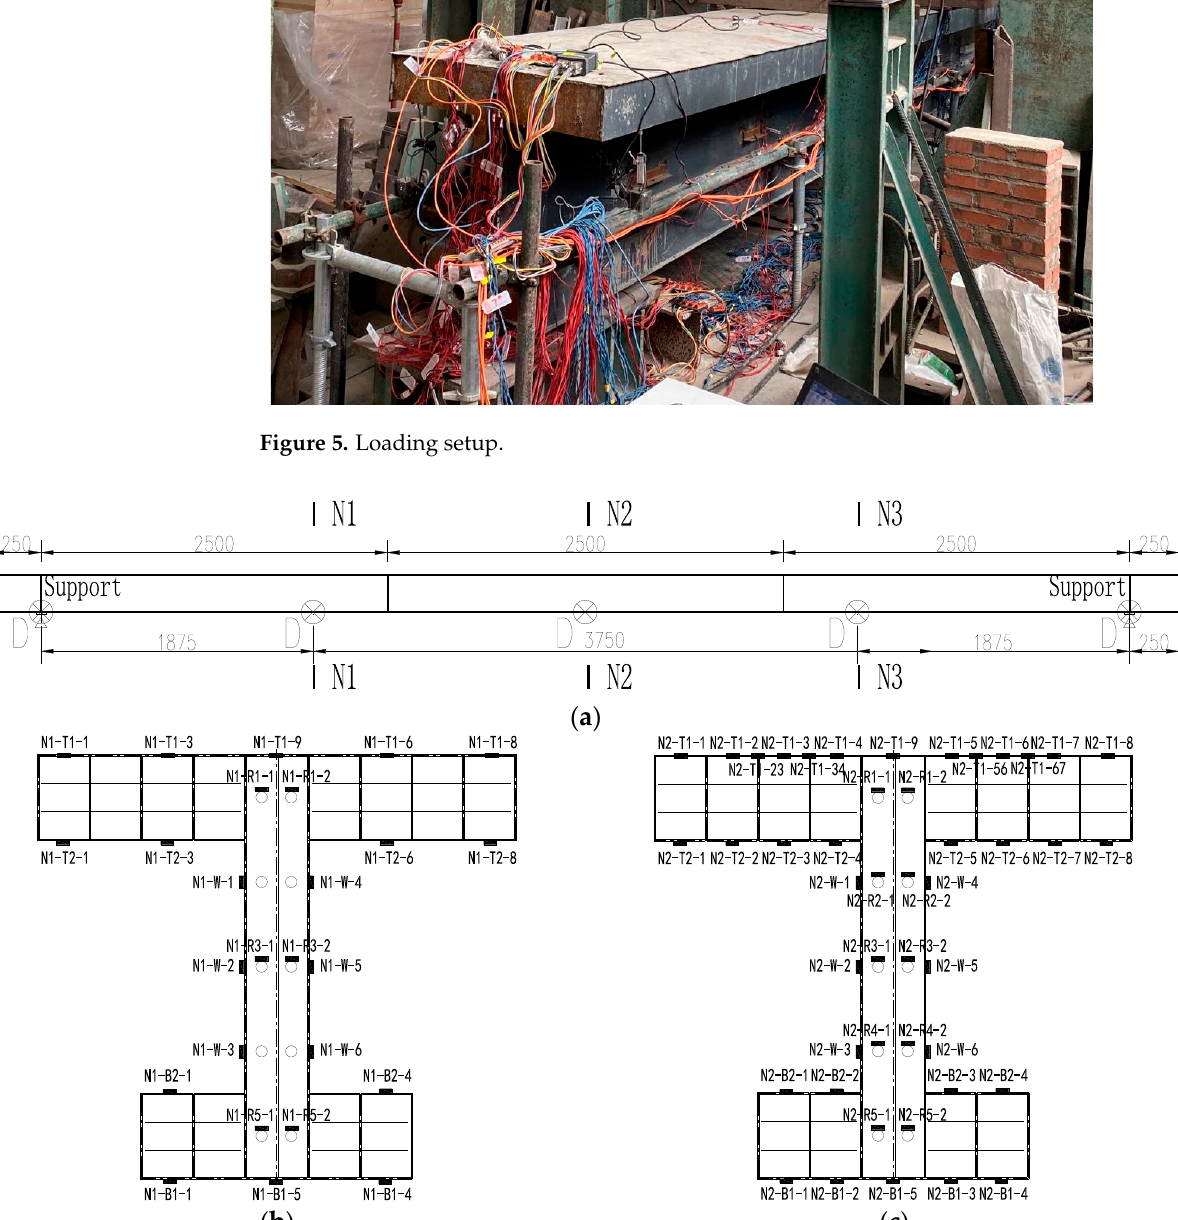
Figure 6. Sensor positions (mm). ( a ) Identification of sections of interest (mm), D: linear variable differential transducers (LVDT); ( b ) strain gauge arrangement at quarter-span; ( c ) strain gauge arrangement at mid-span.